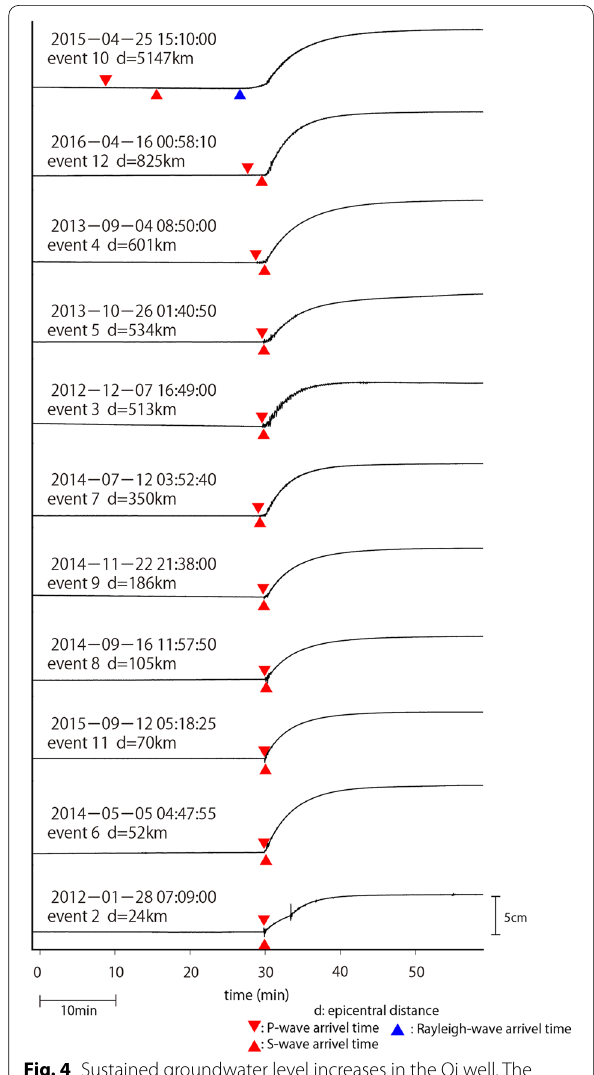
Fig. 4 Sustained groundwater level increases in the Oi well. The groundwater level changes from the 11 events are plotted of epicenter distance, from the bottom to the top in the figure. The start times of the groundwater level increases are aligned to be at the center of the time axis. The amplitudes of the groundwater level increases are plotted at the same scale. The red down-pointing and up-pointing triangles mark the calculated arrival times of the P and S waves, respectively. The blue triangle indicates the Rayleigh wave arrival time shown in Fig.